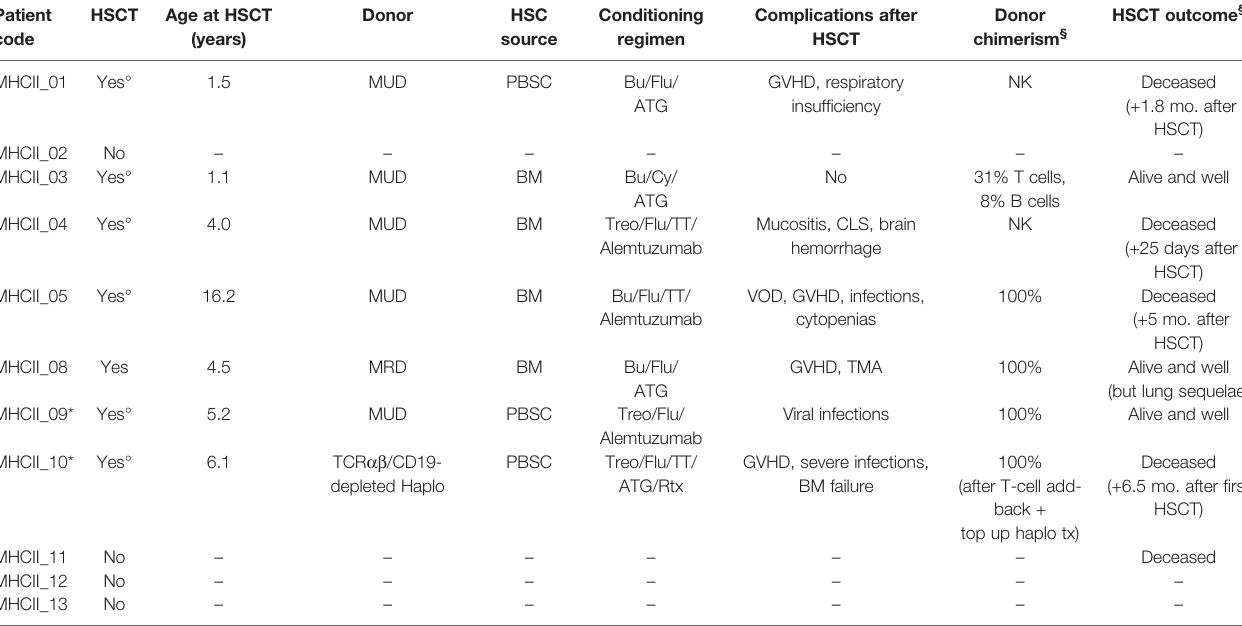
TABLE 4 | MHCII-D patients ’ treatment